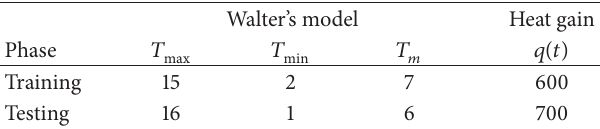
Table 1: Training and testing parameters for outer temperature model and heat gain.